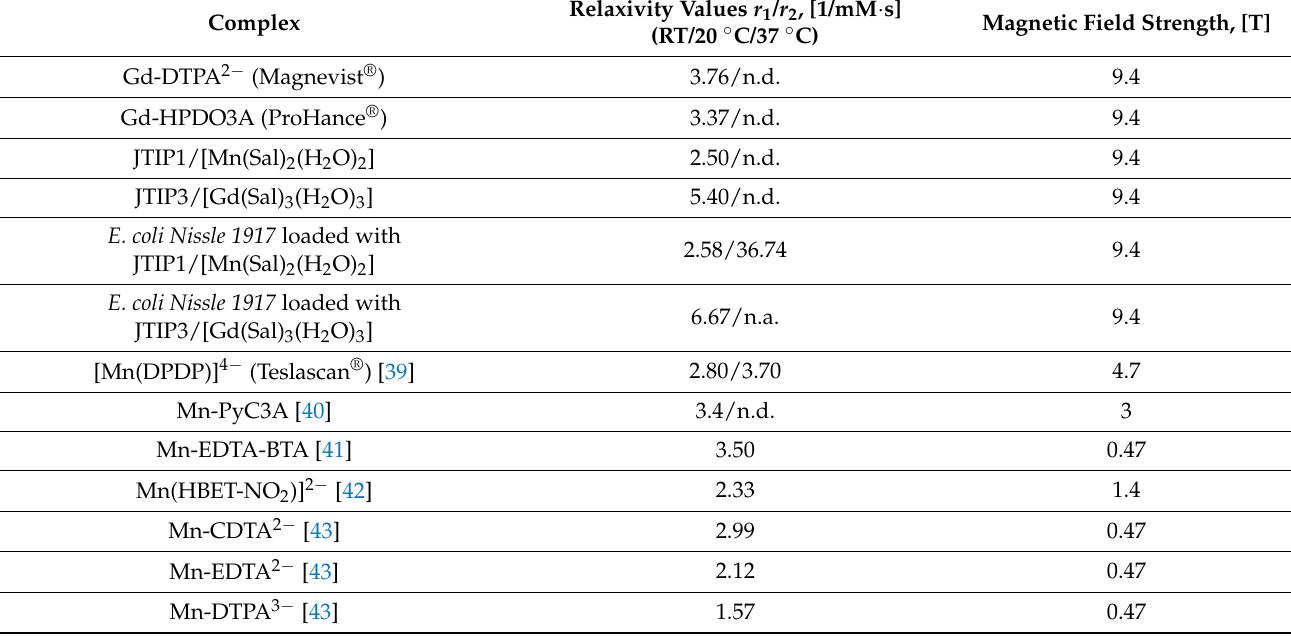
Table 2. Comparison of proton relaxivity r 1 in [1/mM · s] for Sal-Gd(III), Sal-Mn(II), and E. coli Nissle 1917 loaded with the two Sal complexes with various low-molecular-weight Gd(III) and Mn(II)